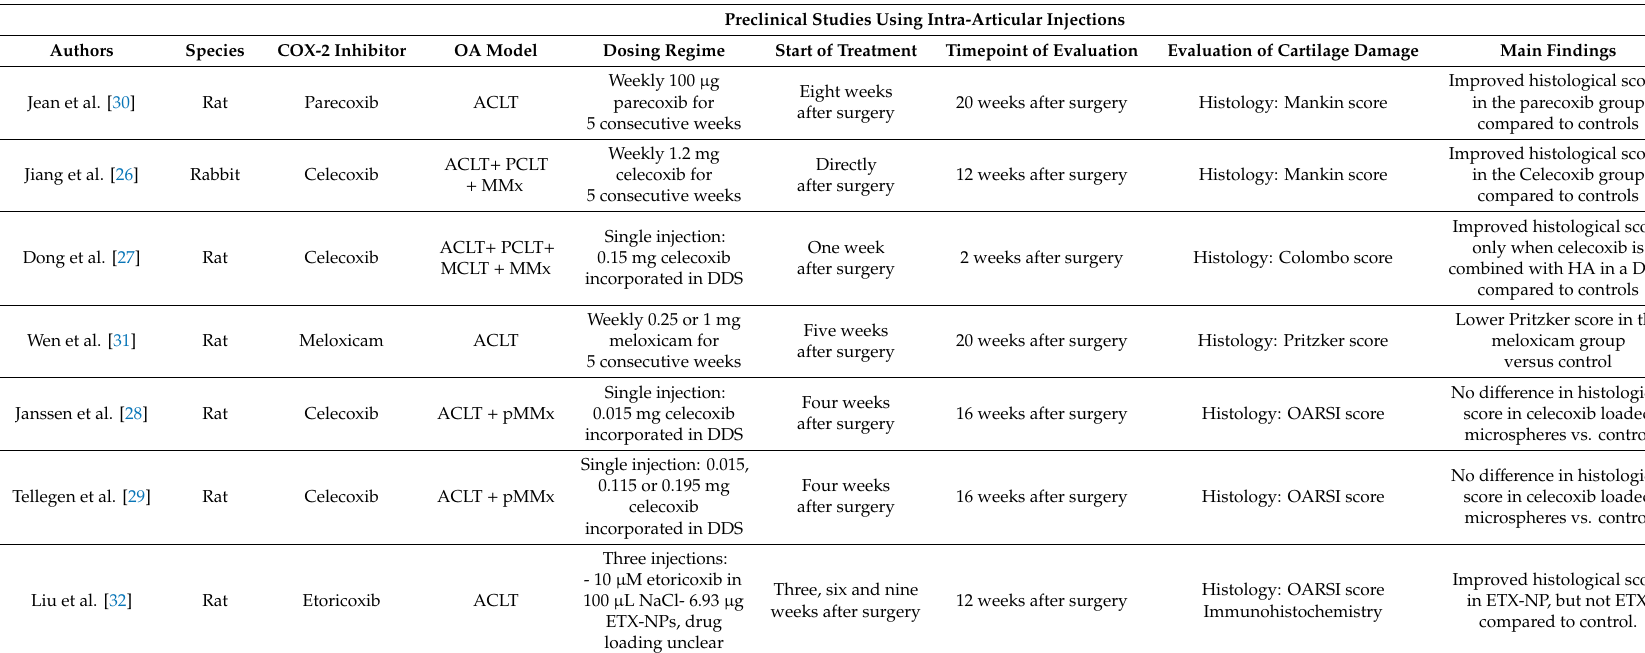
Table 2. The schematic of studies investigating chondroprotective e ff ects of intra-articularly administered selective COX-2